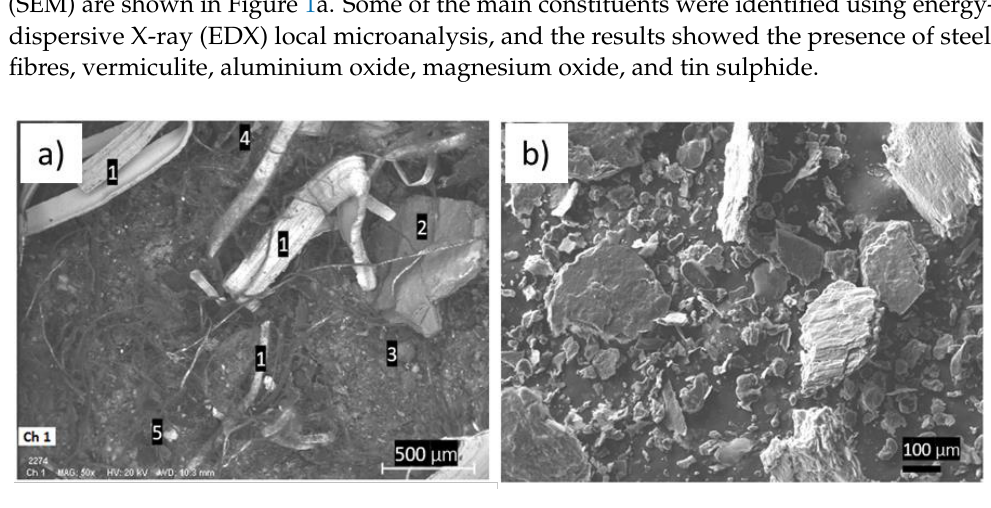
Figure 1. SEM micrographs: ( a ) reference masterbatch (M0) with some identified constituents steel fibre, 2 — vermiculite, 3 — aluminium oxide, 4 — magnesium oxide and 5 — tin sulphide); ( b ) syn- (1—steel fibre, 2—vermiculite, 3—aluminium oxide, 4—magnesium oxide and 5—tin sulphide); thetic graphite particles in the M0_G formulation. ( b ) synthetic graphite particles in the M0_G formulation.